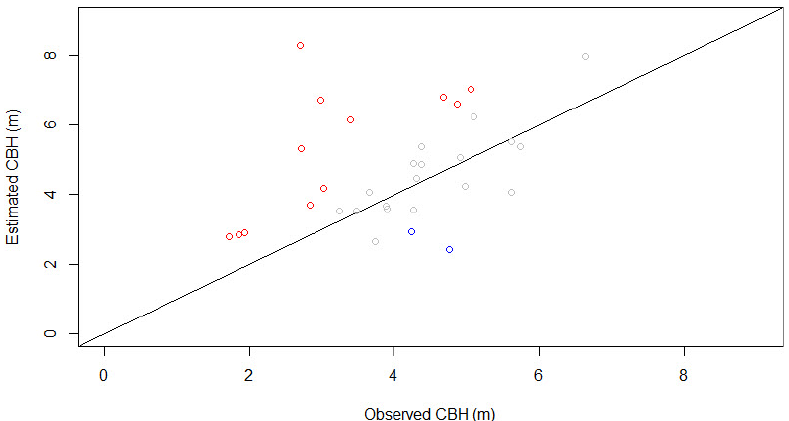
Figure 7. Comparison of measured CBH with the one estimated by the voxel-based method. Overestimated CBH values with error higher than 30% are presented with red color and underestimated with blue.